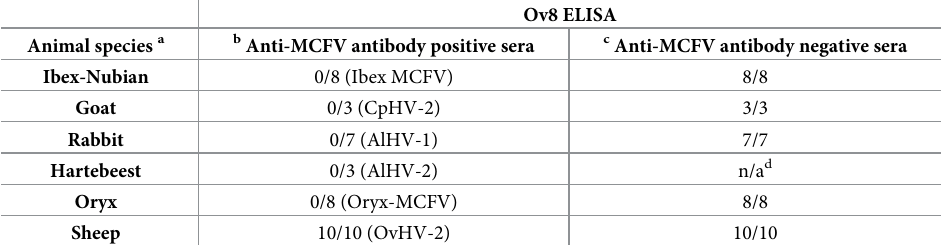
Table 1. Ov8 ELISA specificity using reference serum samples pre-defined as positive or negative by CI-ELISA and PCR. Animal species a